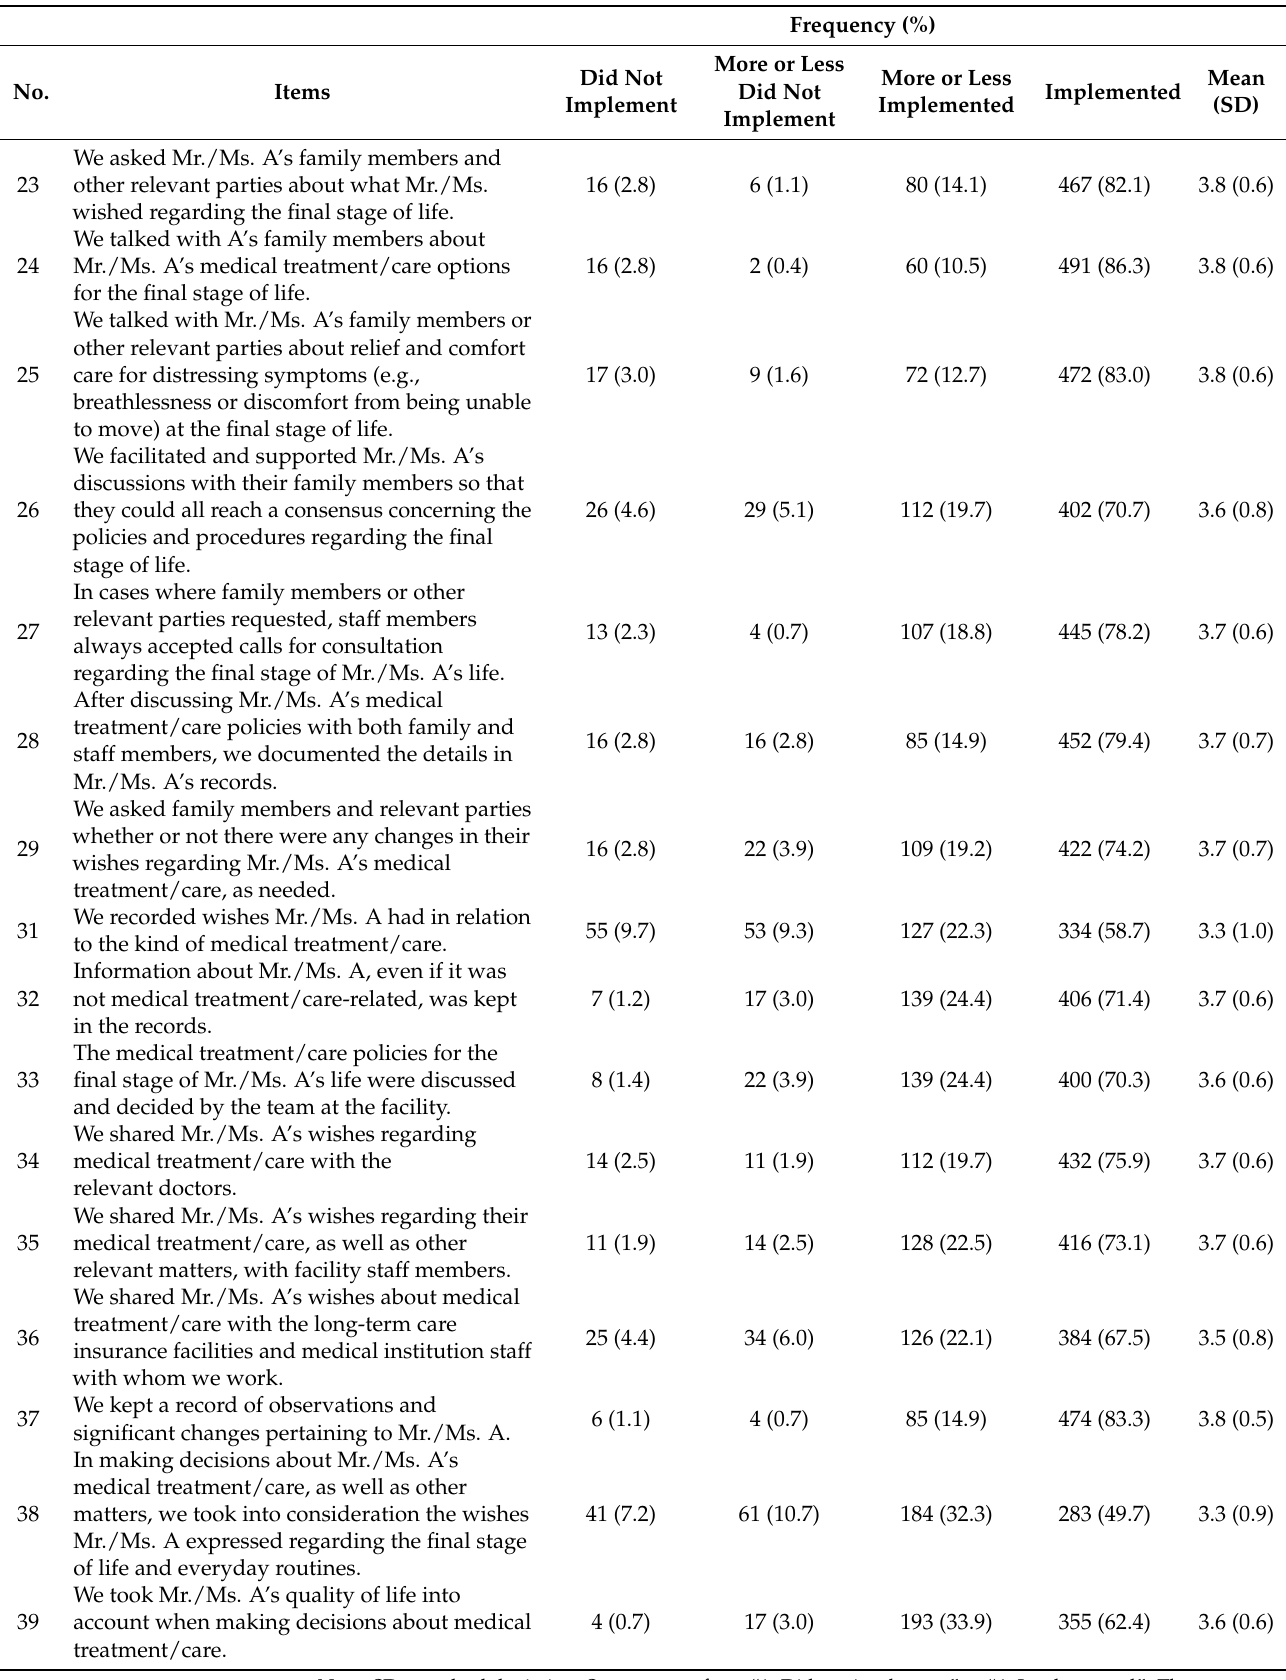
Table 3. Items with ceiling effects ( N =